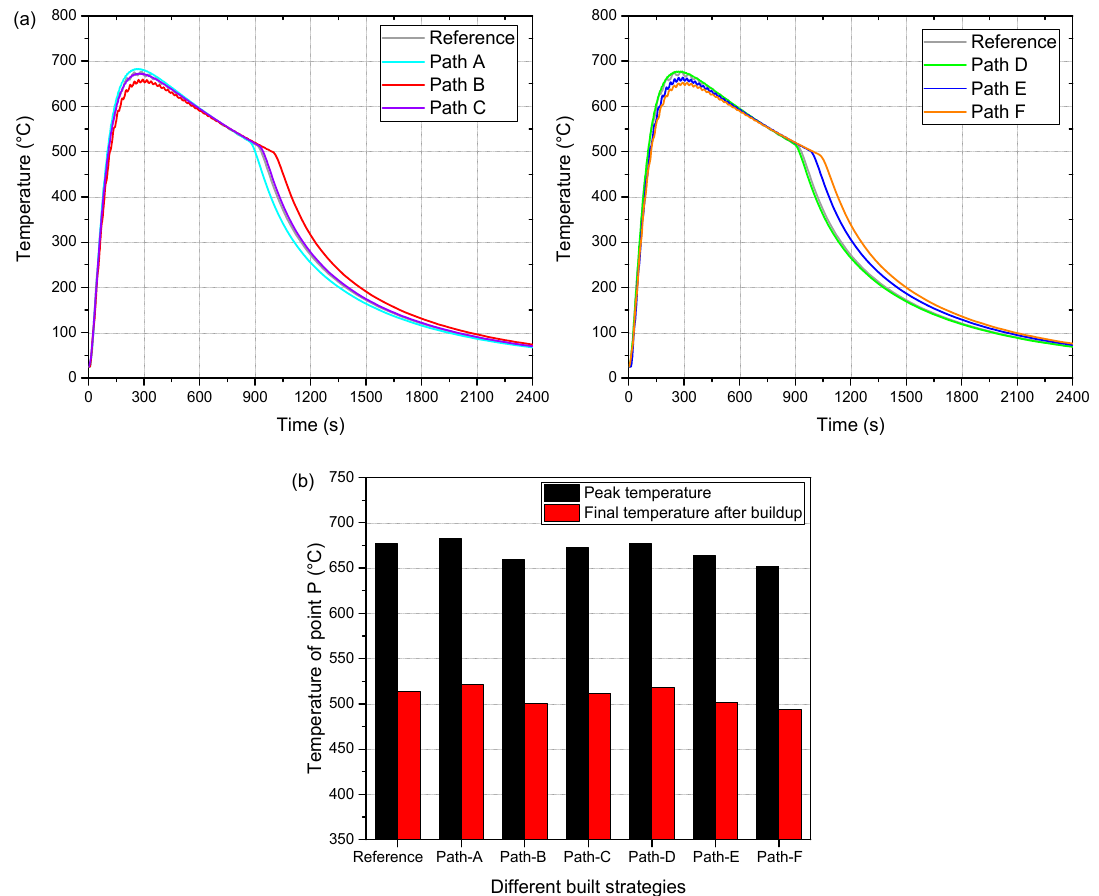
Figure 11. Predicted thermal responses of point P (see Figure 3) for Case 1: ( a ) thermal histories; ( b ) peak and final temperatures after the last layer under different scanning strategies.